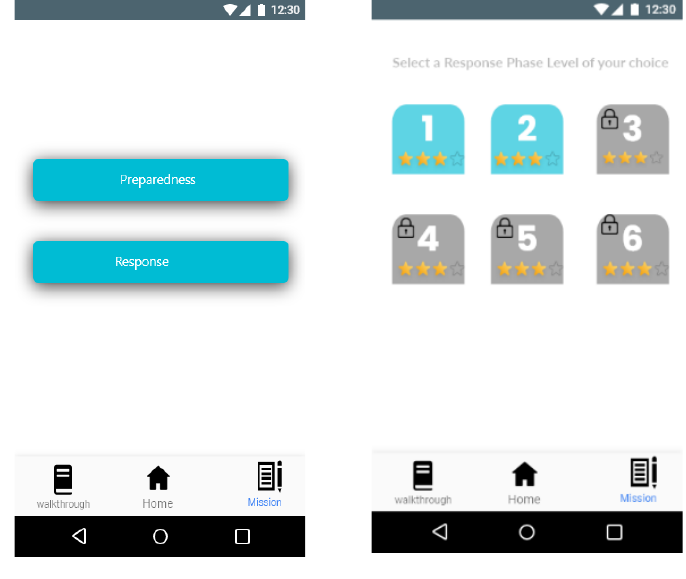
Fig. 5. Gameplay level selection